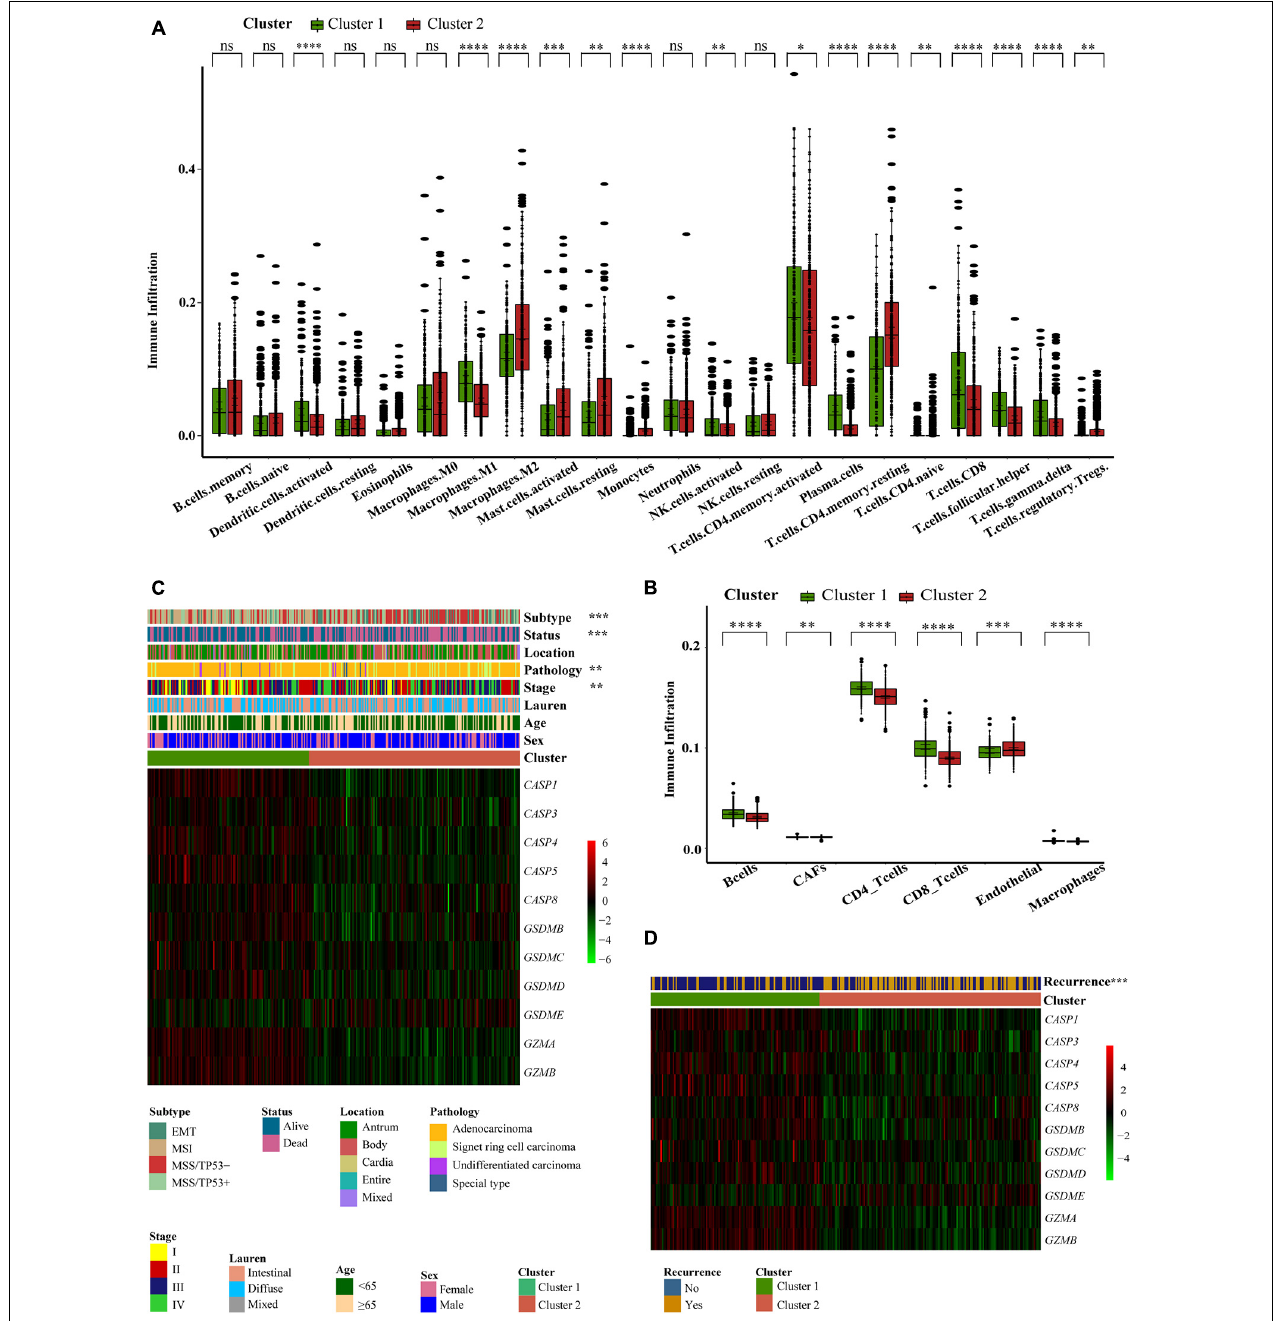
FIGURE 3 | Different pyroptosis-related clusters showed diverse clinical features and TME cell infiltration. (A,B) The abundance of every type of TME infiltrating cells between the two pyroptosis-related clusters analyzed, respectively, by CIBERSORTx and EPIC in GEO cohorts (GSE15459, GSE34942, GSE57303, and GSE62254) (Wilcox test, ∗ P < 0.05; ∗∗ P < 0.01; ∗∗∗ P < 0 · 001; ∗∗∗∗ P < 0.0001; ns, not statistically significant). (C) Consensus clustering of differential expression genes between the two pyroptosis-related clusters in GSE62254 cohort. Columns of the heatmap represented 300 gastric cancer samples (Chi-square test